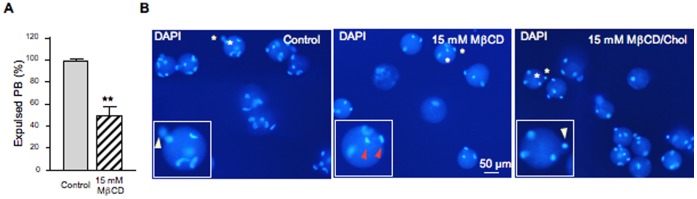
Effect of cholesterol depletion and repletion on polar body extrusion.Zona-free mouse oocytes were incubated with 15 mM of MβCD for 30 min at 37°C to remove cellular cholesterol. Cholesterol repletion was carried out incubating MβCD-treated oocytes with MβCD/Chol complexes. After depletion/repletion treatments, oocytes were washed and inseminated. (A) Percentage of expulsed polar bodies (PB) after fertilization of cholesterol depleted oocytes. (B) Effect of cholesterol depletion and repletion on the extrusion of the second polar body visualized by DAPI staining. Inserts show a zoom of the regions indicated by asterisks. White arrowheads indicate PB and red arrowheads indicate meiosis arrest. Data in A represent the mean ± SEM of 3 independent experiments from a total of 55 control oocytes and 57 oocytes depleted at 15 mM MβCD. Asterisks (**) indicate significant differences with respect to control (P<0.01).